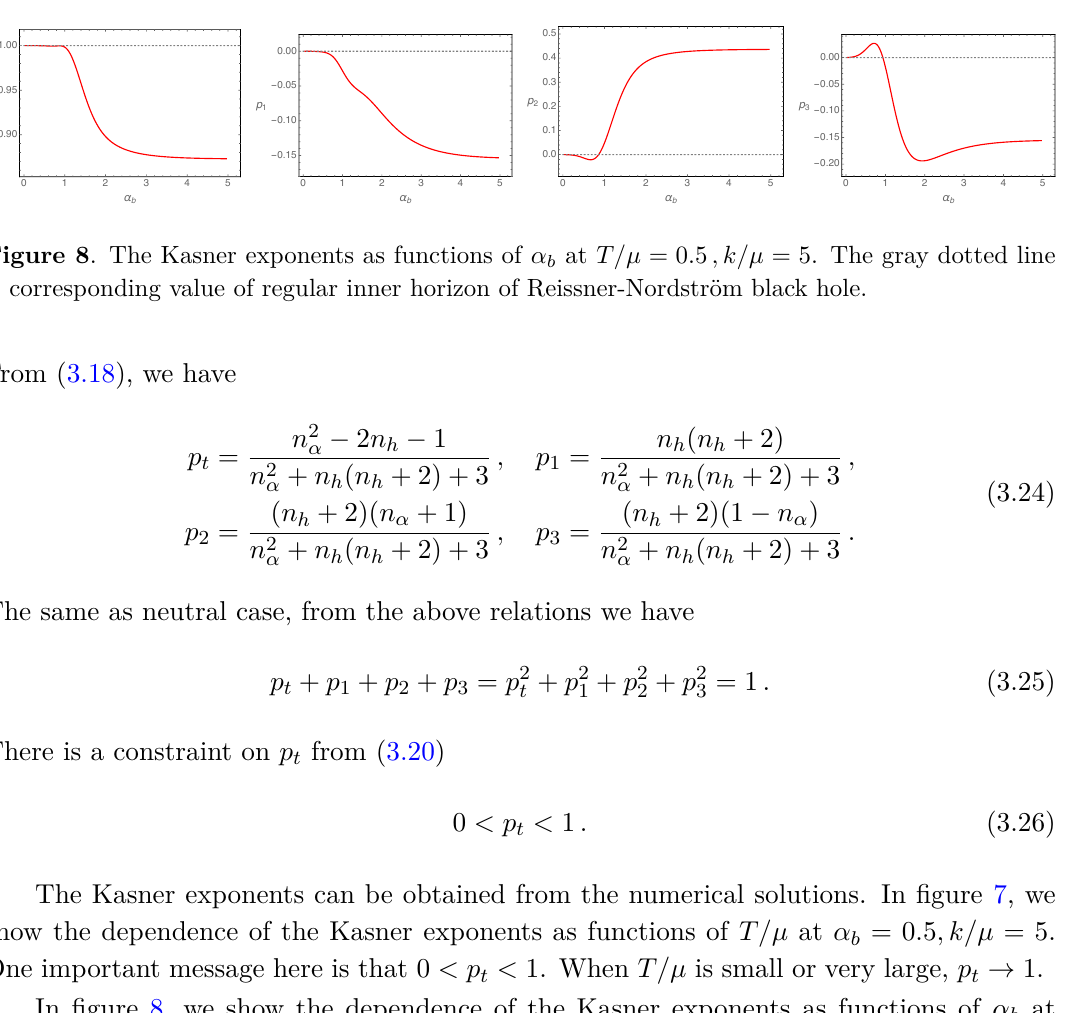
Figure 7 . The Kasner exponents as functions of T/µ at α b = 0 . 5 , k/µ = 5 . The gray dotted line is corresponding value of regular inner horizon of Reissner-Nordström black hole with p t = 1 , p 1 = p 2 = p 3 = 0 .